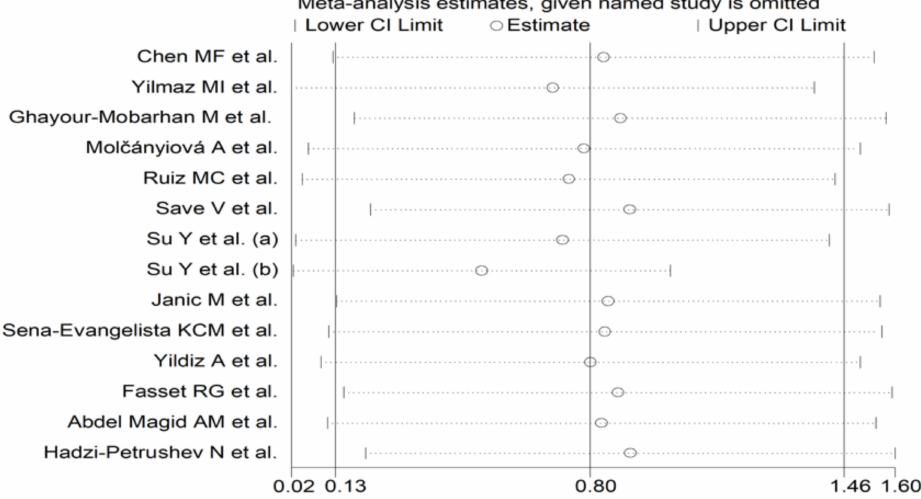
Figure 3. Influence of individual studies on the standardized mean difference (SMD). The hollow circles represent the SMD when the remaining study is